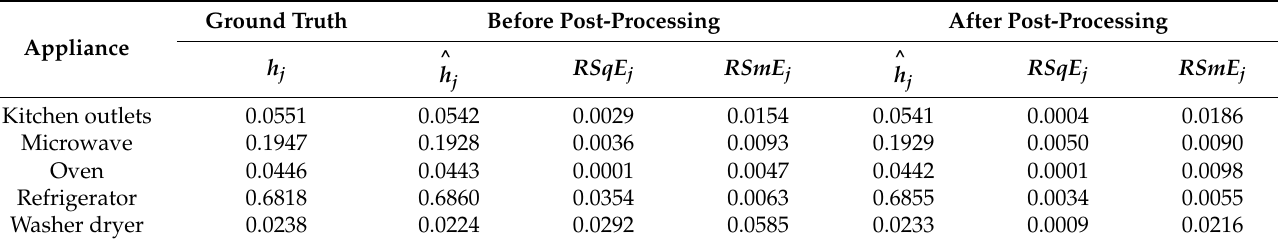
Figure 5. Estimated ALDs for testing data 2 before post-processing. Table 4. Results for different evaluation